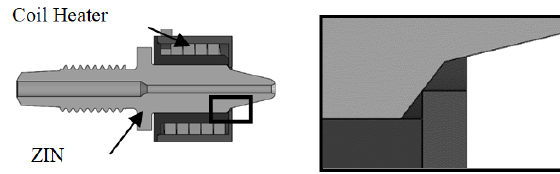
Figure 10. Technical problems with the seal of the contact between the heating set and the ZIN.